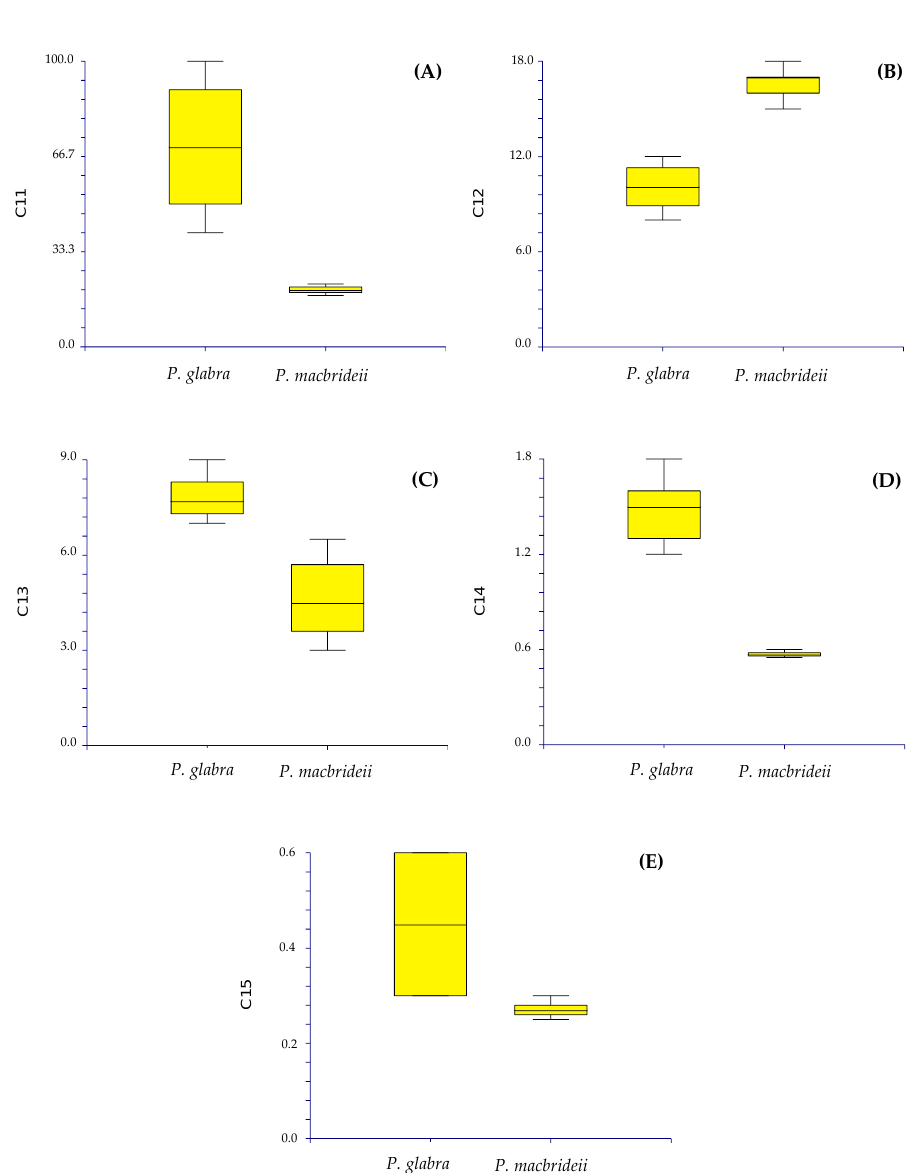
Figure 6. Paronychia glabra vs. P. macbridei . Box plots illustrating the variability of the diagnostic character: size of the stem ( A ), length of the internodes ( B ), length of the leaves ( C ), length of the petals ( D ), length of the styles ( E ). Yellow boxes illustrate interquartile ranges (=the range between the 25th and 75th percentile) and medians (horizontal line); vertical lines are the whiskers which represent the scores outside the middle 50% (i.e., the lower 25% of scores and the upper 25% of scores). Distribution and ecology. Paronychia glabra is found in the mountain regions of north Peru, in what is denominated as “jalca” by the abundancy of tussock grasses with